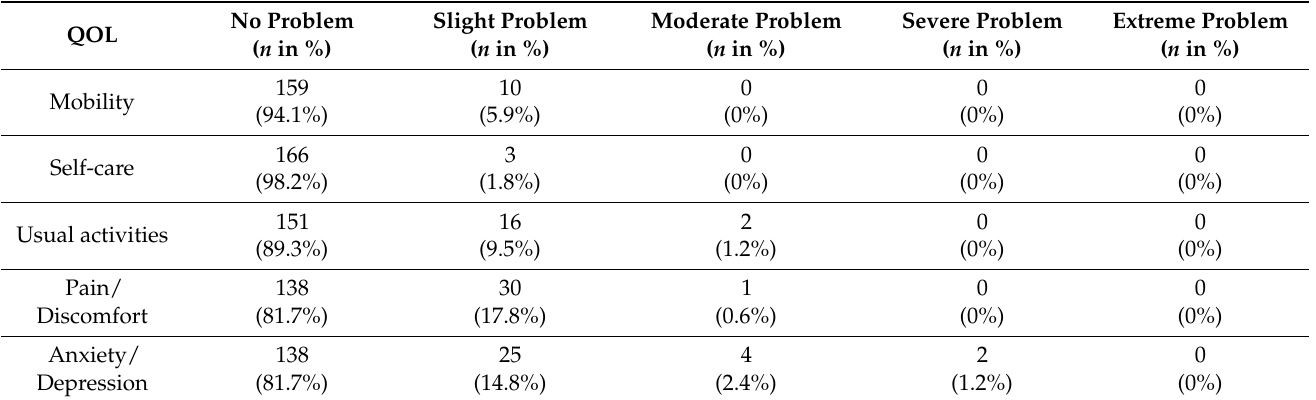
Table 5. Quality of life (QOL) outcomes (EQ-5D-5L) for caregiver.